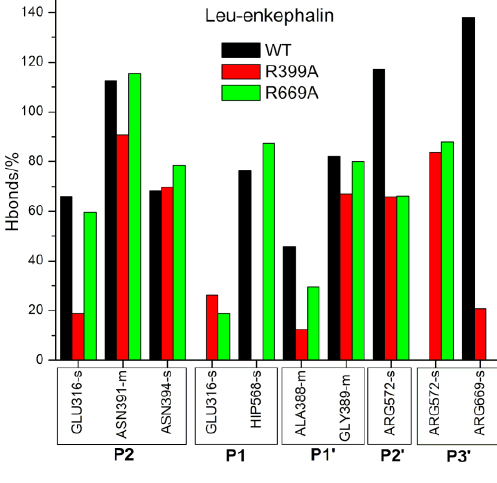
Figure 2. The MM/GBSA per-residue binding-free energies indicate how much each ligand residue contributes to the binding-free energy. Calculations were performed using the set of conformers sampled during the last 800 ns of the MD simulations of the complexes. The amino acid residues of the peptide ligand are denoted as P1 to Pn and P1’ to Pn’, counting from the scissile peptide bond to the N- and C-termini of the peptides, respectively.